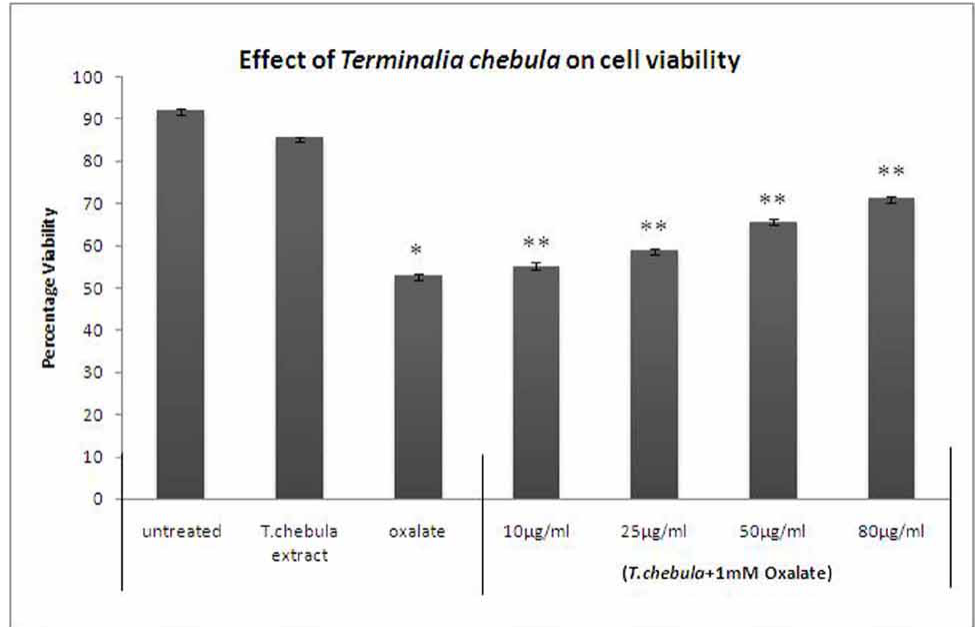
Figure 3 – Effect of Terminalia chebula on the viability of MDCK. Data are mean ± S.D. of three inde- pendent observations. * p < 0.05 versus untreated control, ** p < 0.05 versus oxalate